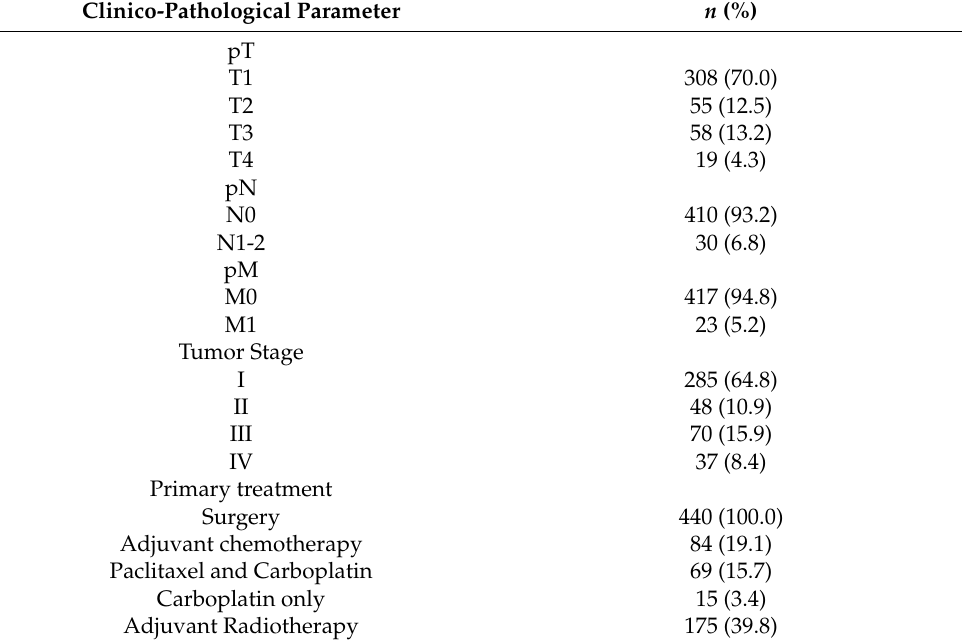
Table 1. Cont. Clinico-Pathological